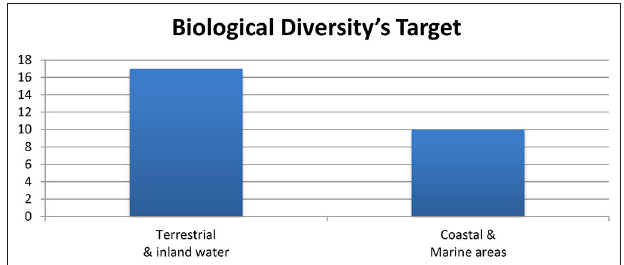
FIGURE 9 | Biological diversity target for the year 2011–2020 (34).